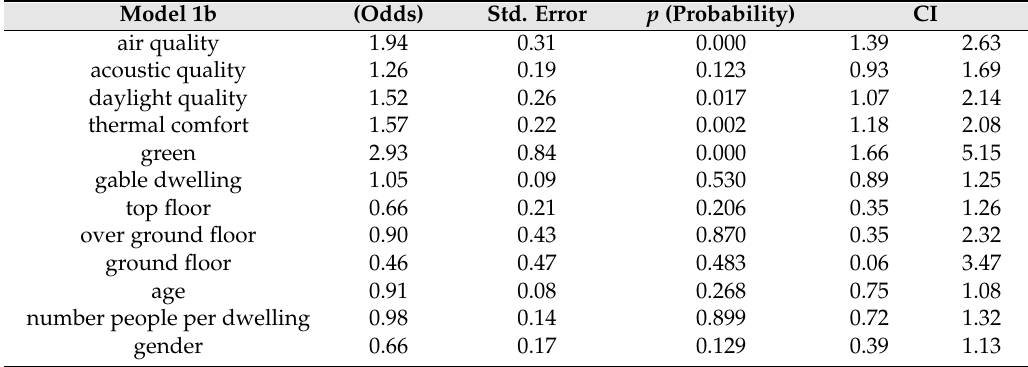
Table 8. Model 1b, ordinary logistic model describing relationship between general satisfaction and perceived IEQ and environmental profile of building, N = 387; pseudo R-squared = 0.1862.